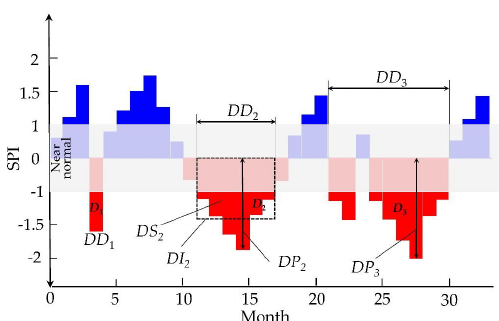
Figure 3. Illustration of drought characteristics based on the SPI categories and run theory.